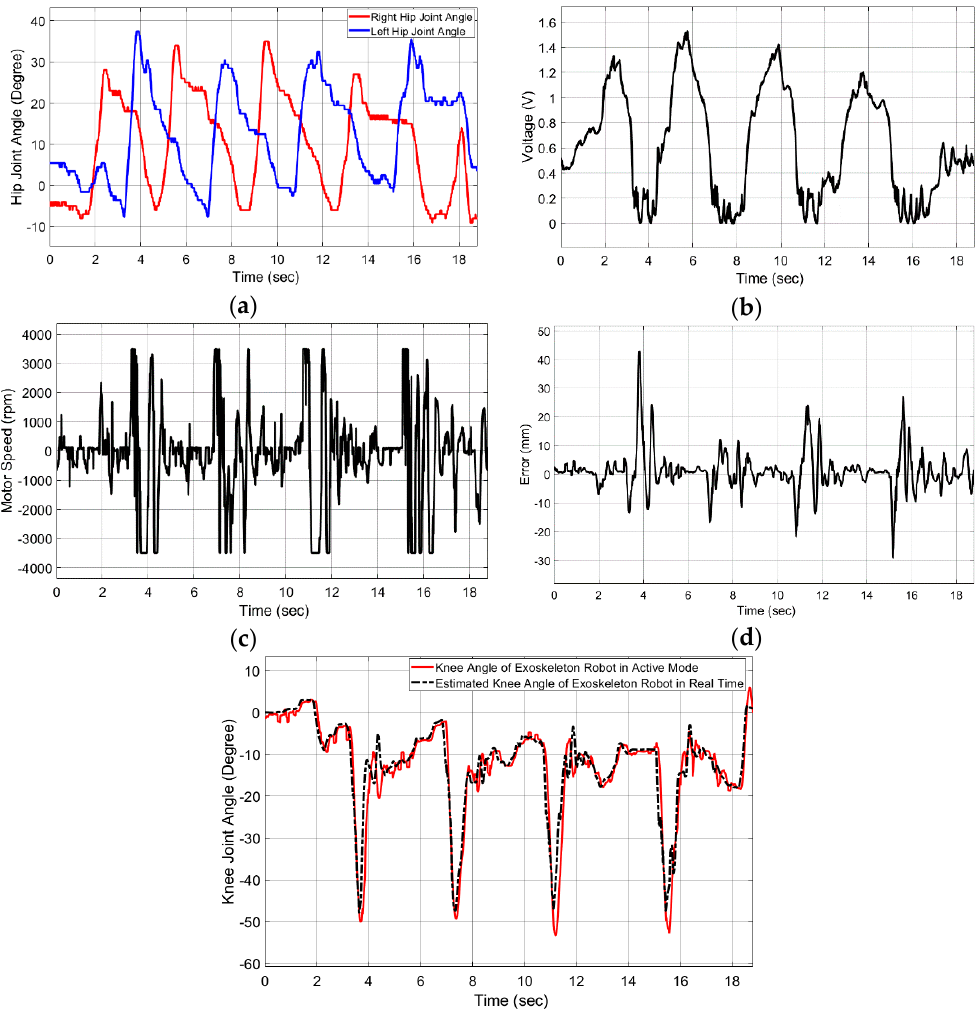
Figure 11. Exoskeleton robot in the walking experiment on level ground: ( a ) the change of the hip joint angles, ( b ) the sum of the plantar pressure sensors, ( c ) the motor speed, ( d ) the tracking error, and ( e ) a comparison of the actual and the estimated knee joint angles of the exoskeleton robot.